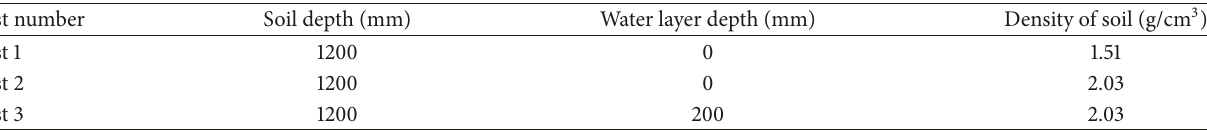
Table 2: Experiment conditions.